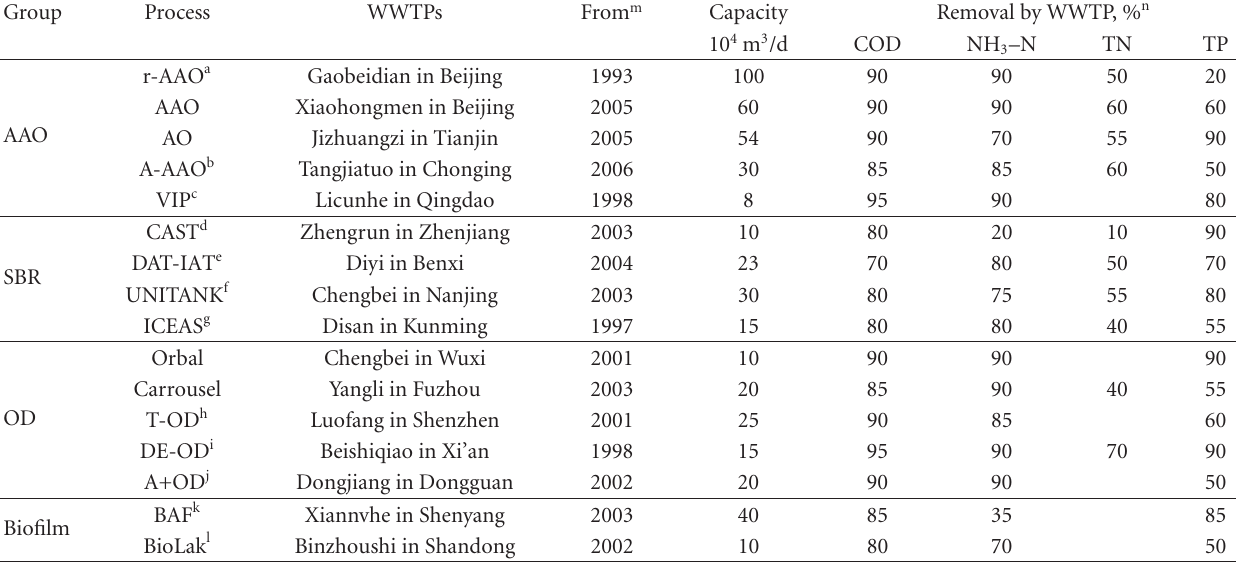
Table 4: Typical processes applied in municipal WWTPs and their performances in